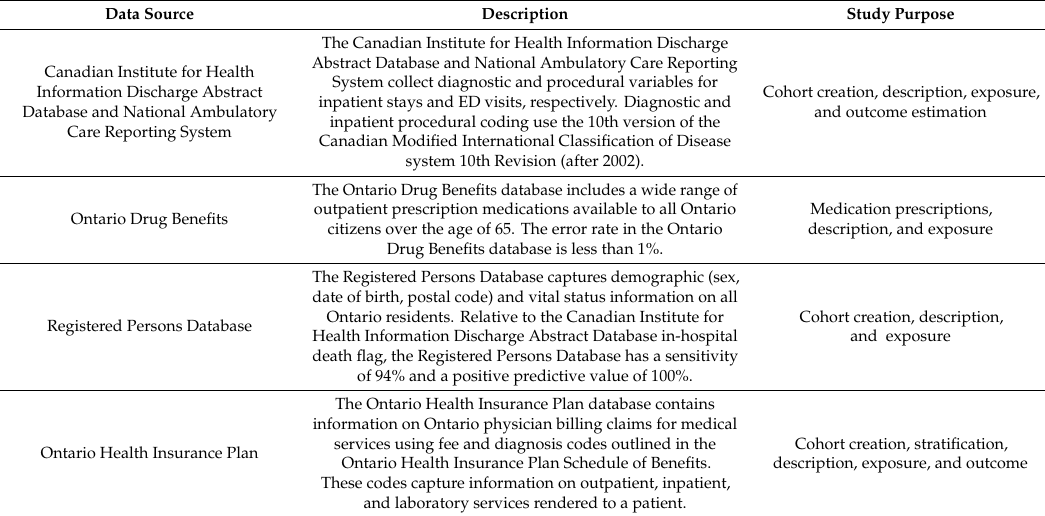
TableA1. ListofdatabasesheldatICES(anindependent, non-profit, world-leadingresearchorganization that uses population-based health and social data to produce knowledge on a broad range of healthcare